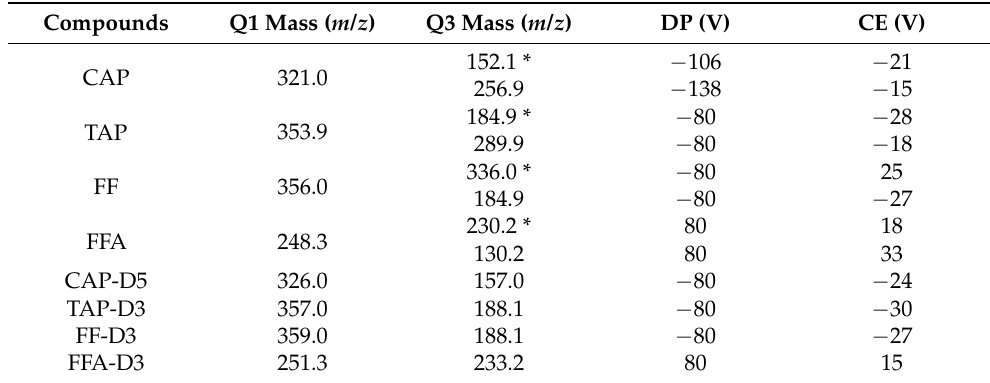
Table 5. Mass spectral parameters for